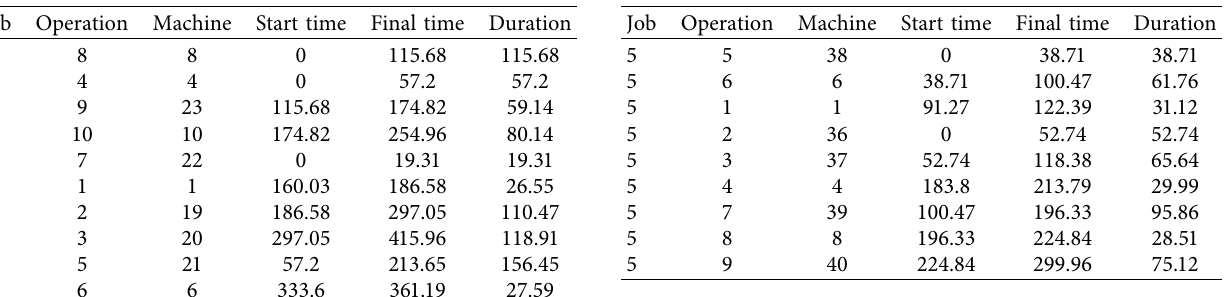
Table 13: Sequence of job 2 operations.